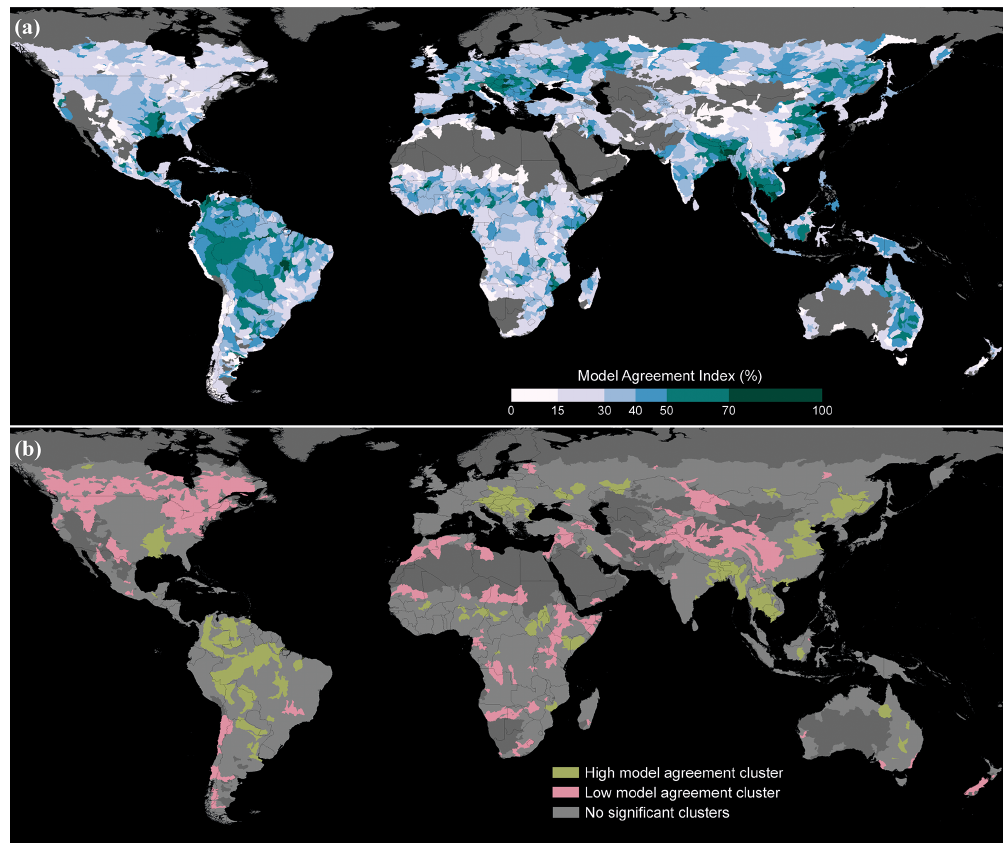
Figure 3. (a) Spatial distribution of MAI-500, the model agreement between the hydrogeomorphic floodplain map GFPLAIN and the flood hazard maps the GAR and JRC with a 500-year return period. The model agreement index ranges between 0% (no agreement) and 100% (full agreement) and was calculated here for all the river basins of the world that are covered by all three models. (b) Local clusters of river basins with high or low agreement values relative to the mean, identified from the spatial autocorrelation